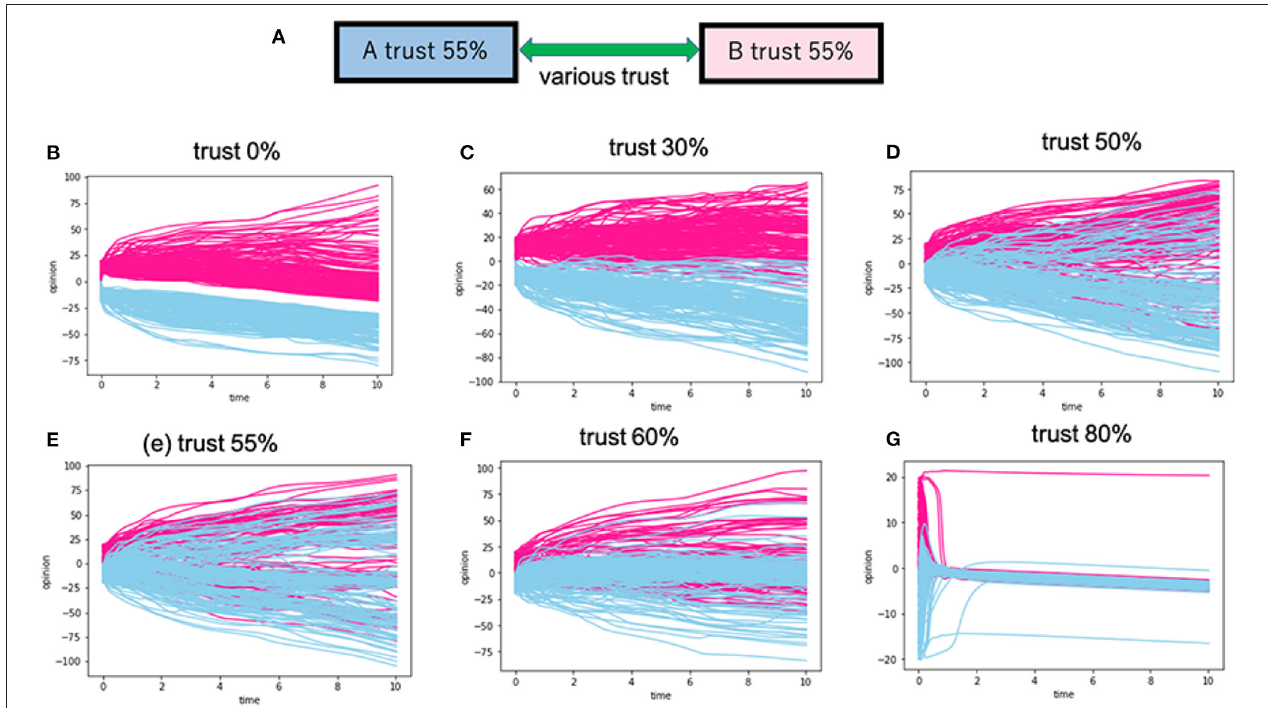
FIGURE 6 | Various calculations for the intergroup trusts between group A and group B. (A) Is the model’s schematic view. (B–G) Correspond to the various intergroup trusts (Dij) between group A and the group B. For example, the trust of 30% in (C) means that the intergroup trust ( D ij ) between group A and group B posits a positive value of 30%. The red lines correspond to the opinion trajectories for group A, and the blue lines correspond to those of group